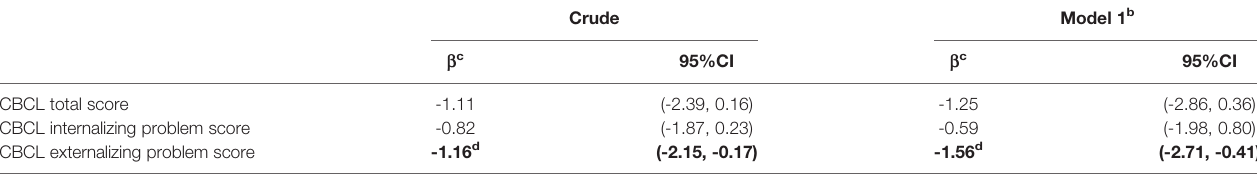
TABLE 4 | Association between maternal change in oxytocin level following mother – child interaction in 2015 and the CBCL score in 2 years in 2017 (n=14 a ).